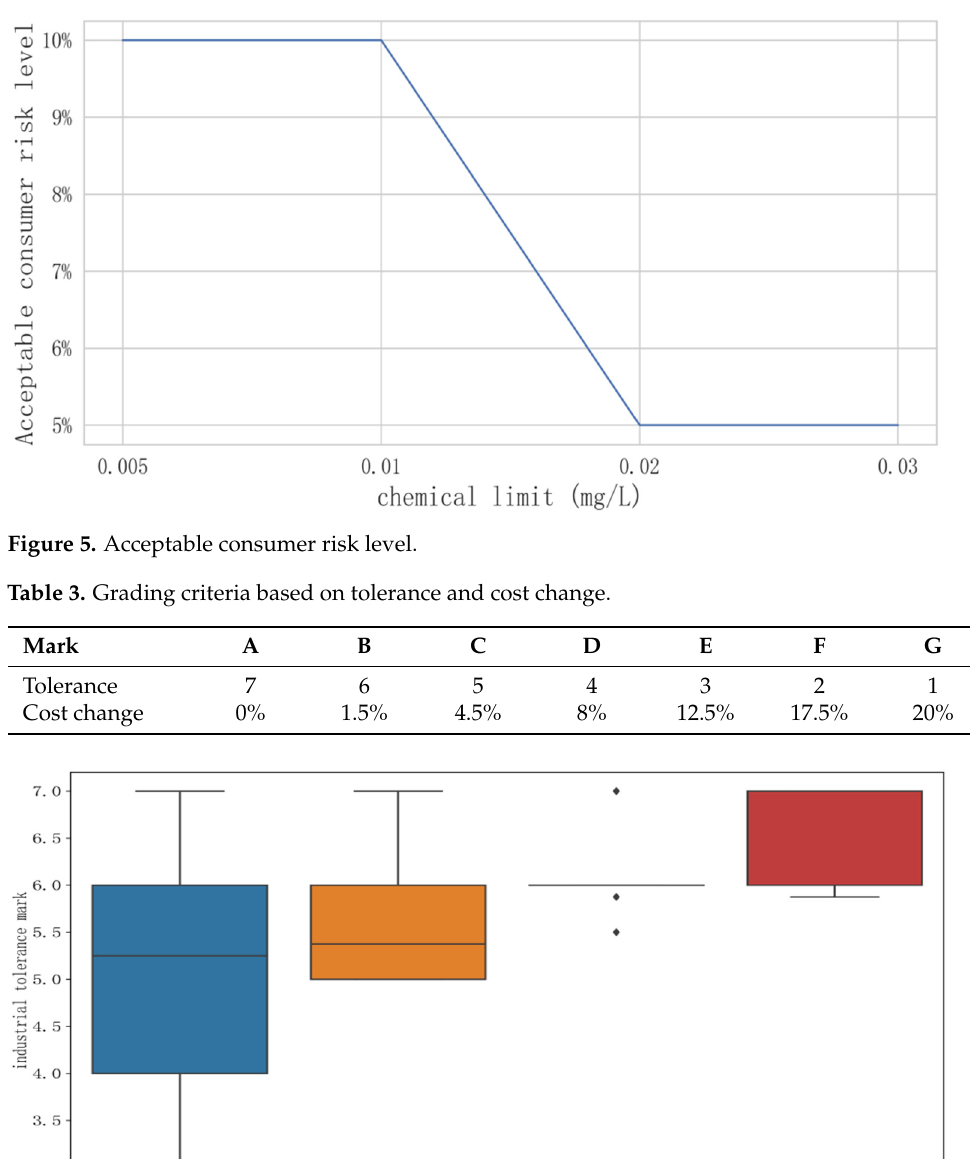
Table 3. Grading criteria based on tolerance and cost change.